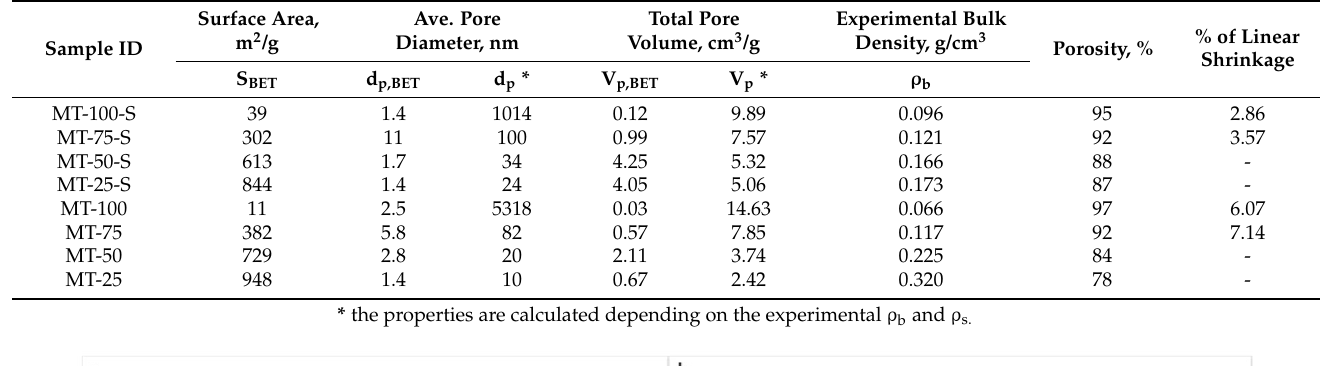
Table 1. The physicochemical properties of the silica xerogels.